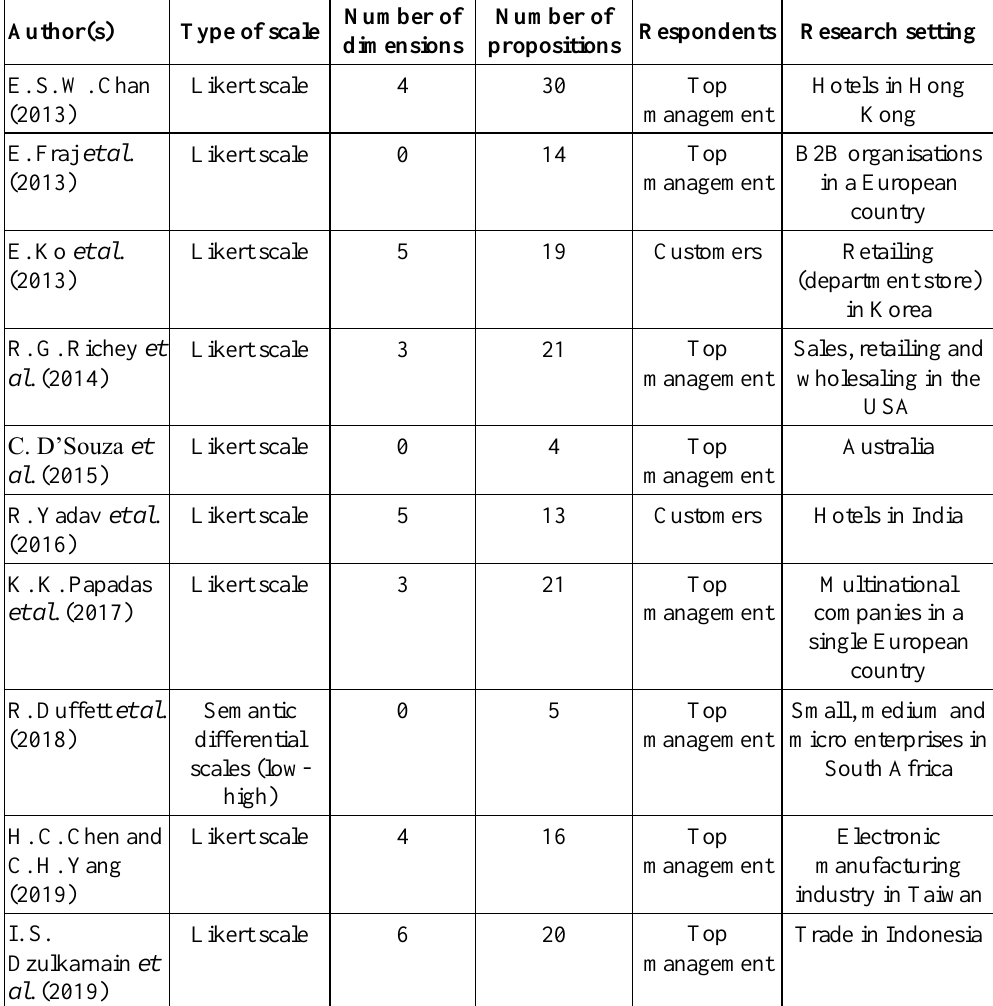
Table 2. Scales for the Evaluation of Green Marketing